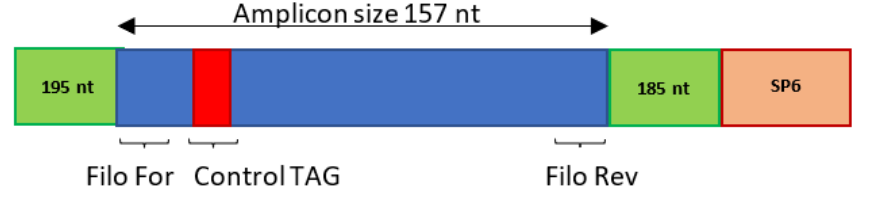
Figure 1. Graphic representation of the synthetic constructs designed for use as assay controls. Each